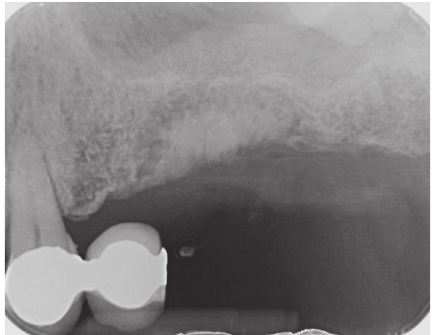
Figure 4: Intraoral radiograph collected two months later showing the limited thickness of the residual posterior ridge.